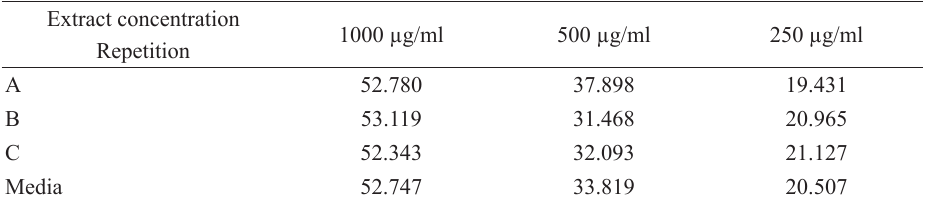
results from assays to determine the total phenolic content from EEstb expressed on terms of gallic acid equivalent (mg of gAE/g of extract).